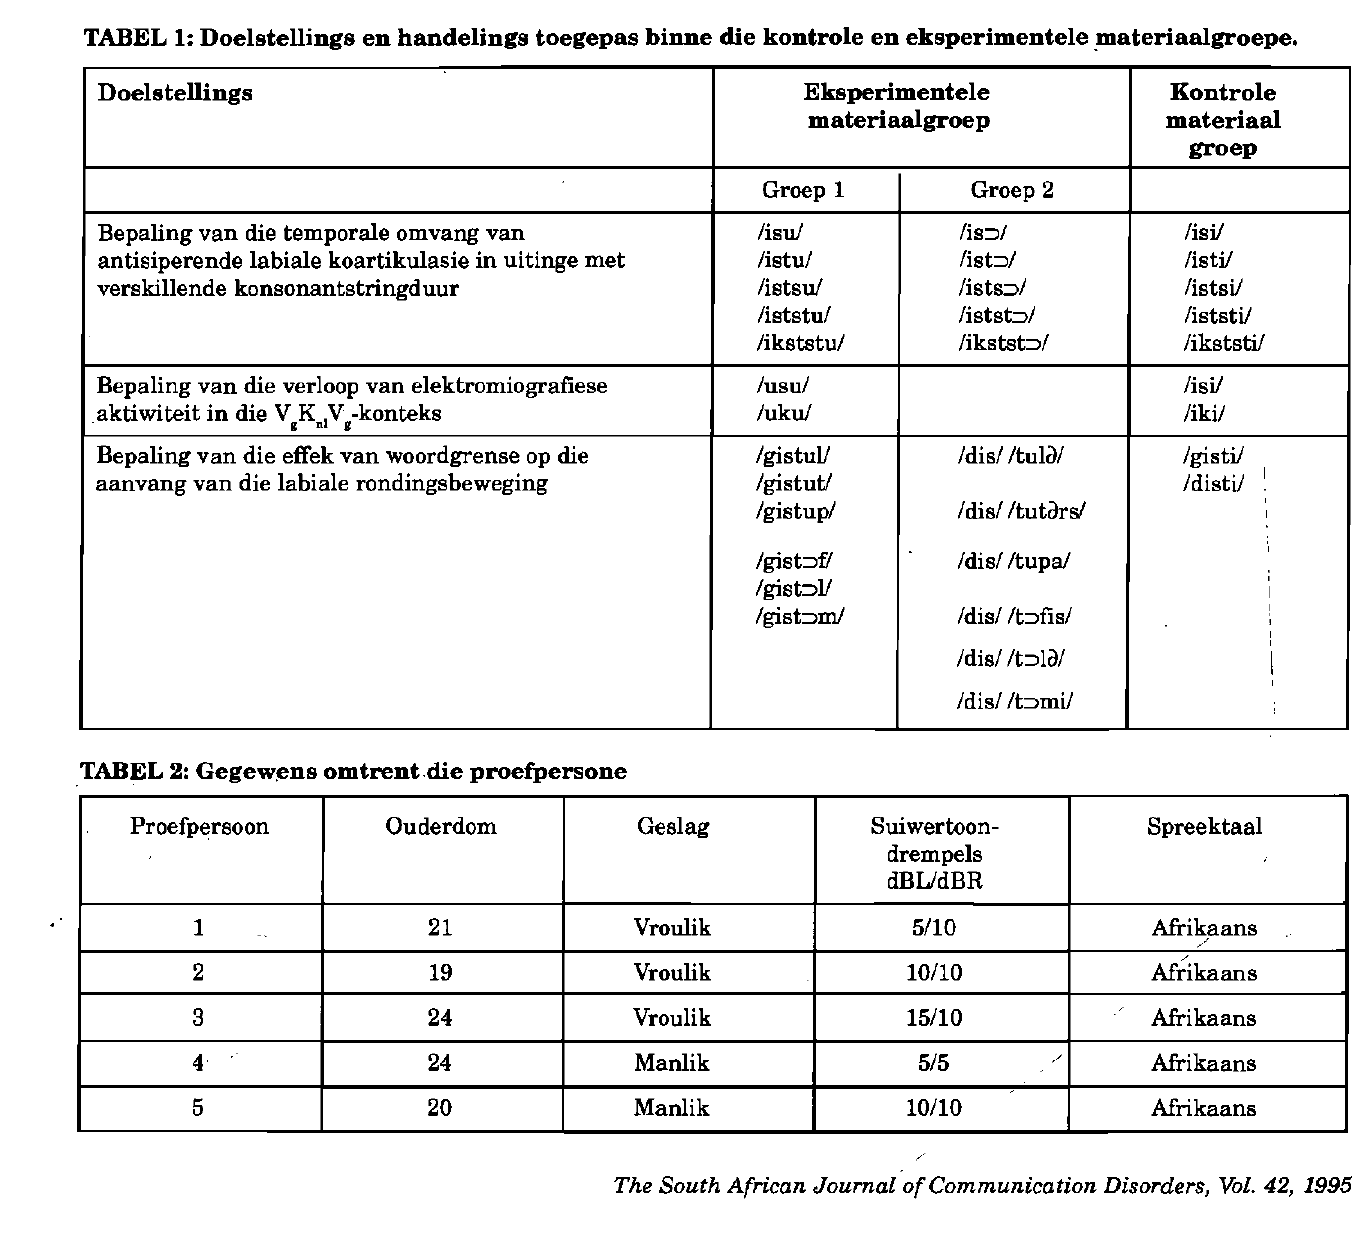
TABEL 1: Doelstellings en handelings toegepas binne die kontrole en eksperimentele materiaalgroepe. Doelstellings